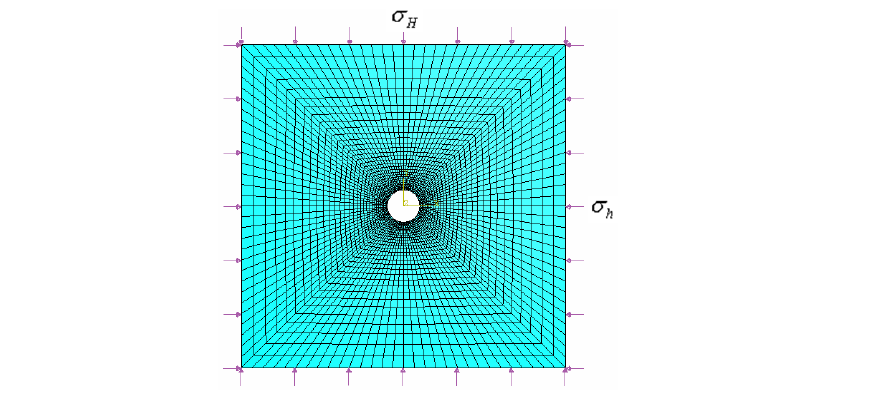
Figure 2: Finite element